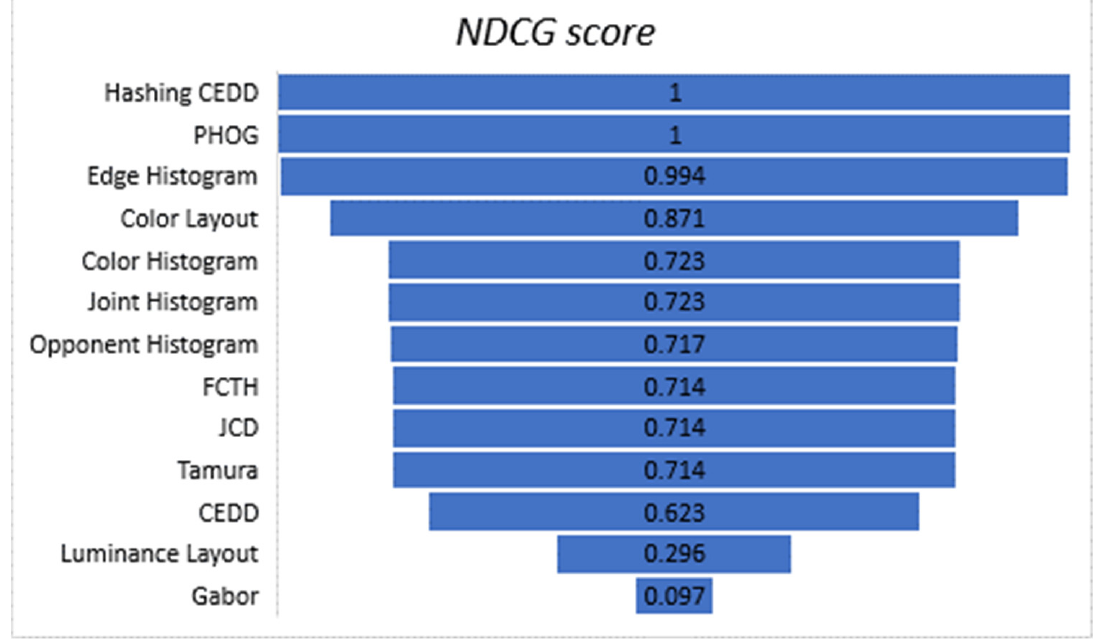
Figure 24. NDCG@k ranking performance.